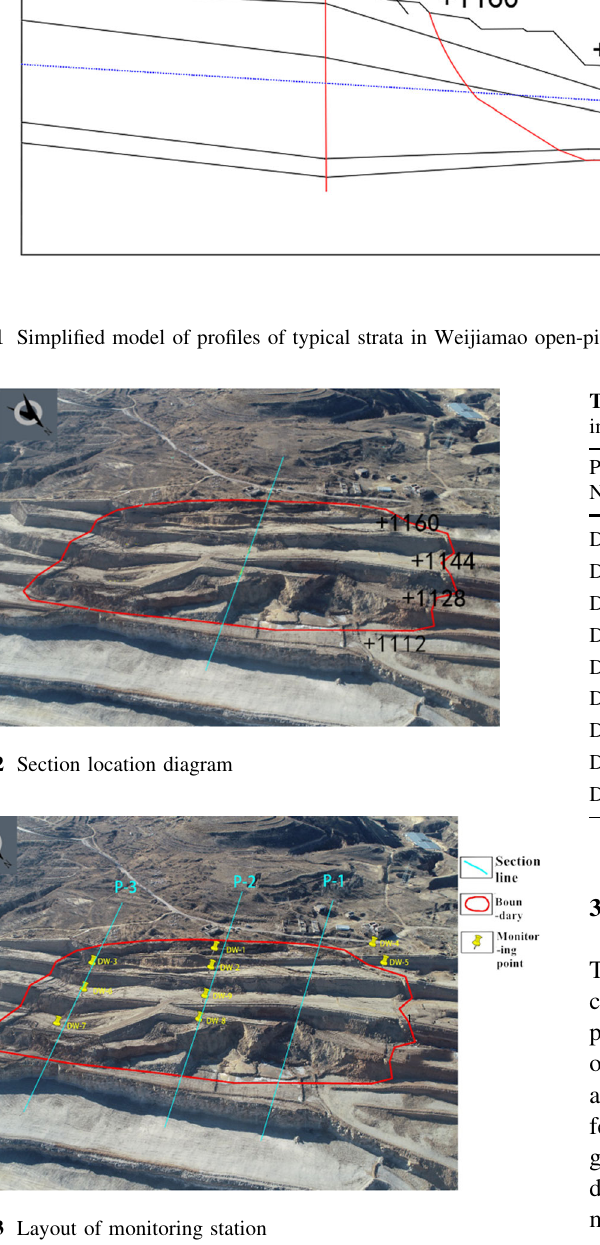
Fig. 3 Layout of monitoring station